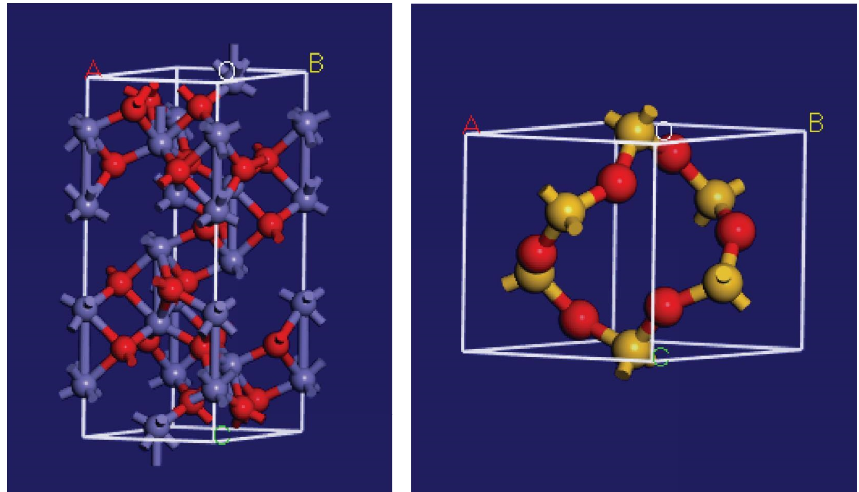
Figure 3: Fe 2 O 3 and SiO 2 cells (iron is purple, silicon is orange, and oxygen is red).